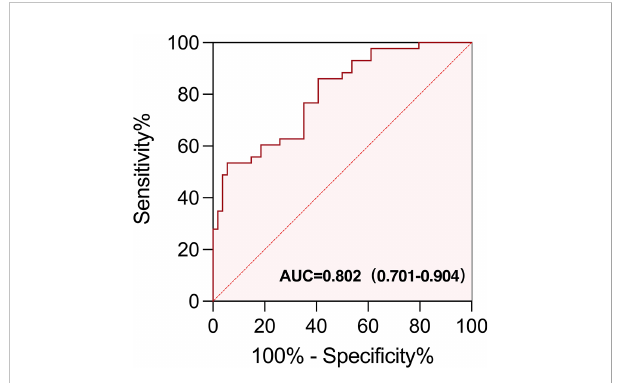
FIGURE 5 ROC curve of EOS% of ≥ 1.15% combined with IFN- g of ≥ 3.75 ng/L for predicting the appearance of irAEs in patients treated with immunotherapy. The area under the curve (AUC) of the ROC curve was 0.802 (95% CI, 0.701 − 0.904; p < 0.0001). The sensitivity and speci fi city were 60.47% and 81.48%,